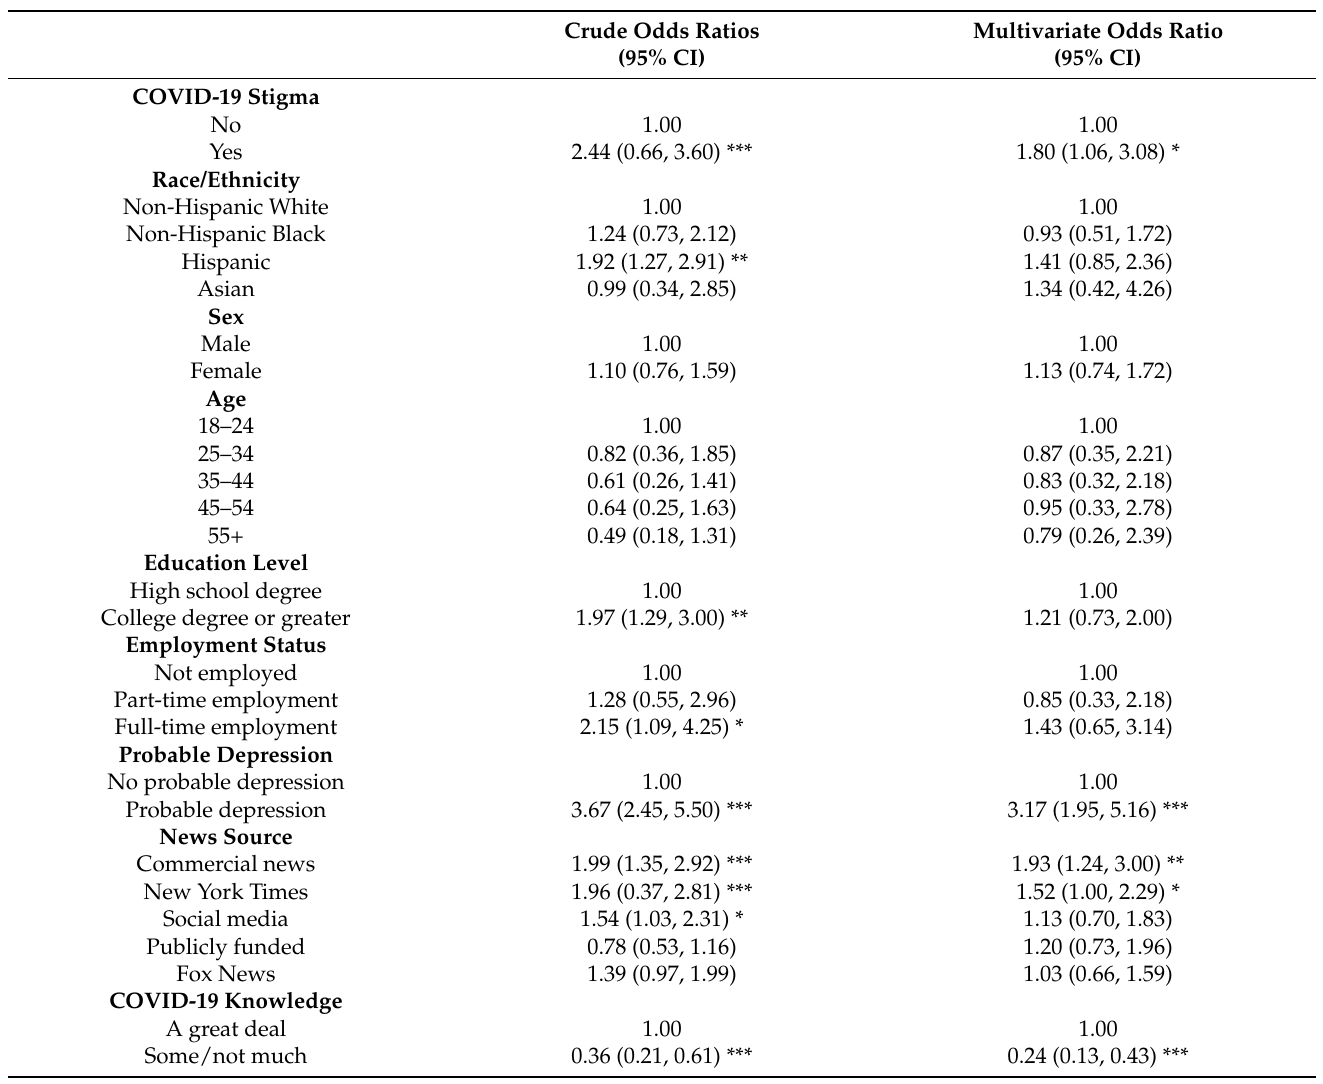
Table 4. Logistic regression predicting being very COVID-19 worried, National, N = 501. Crude Odds Ratios (95%